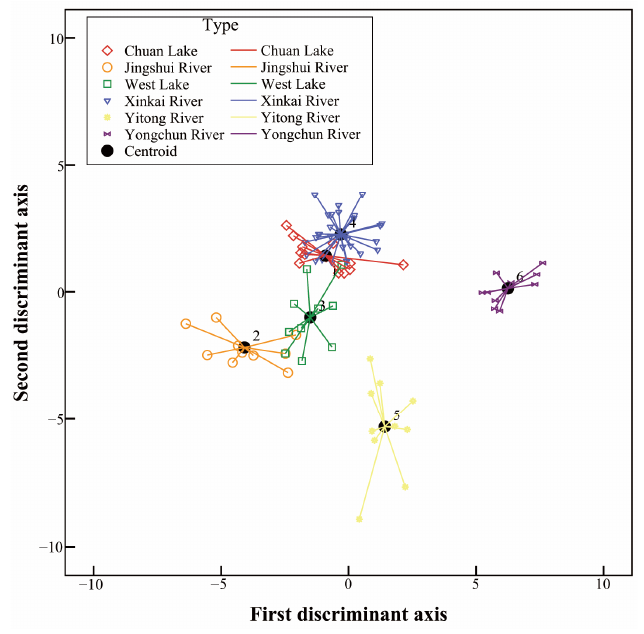
Figure 4. Scatter diagram of discriminant analysis for six rivers in Changchun City.